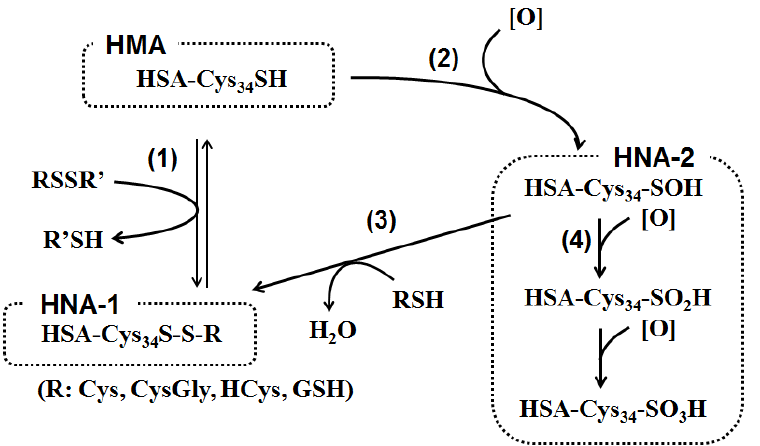
Figure 2. Pathway for human serum albumin (ALB) redox state. (1) The free thiol group in cysteine residue at position 34 (Cys34) of human serum mercaptalbumin (HMA) receives a disulfide exchange reaction with low molecular weight disulfides consisting of cysteine (Cys), cysteinylglycine (CysGly), homocysteine (HCys) and/or glutathione (GSH), to form a mixed disulfide on Cys34. The resulting oxidized ALB is designated as human non-mercaptalbumin-1 (HNA-1). (2) Alternatively, the Cys34 reacts with several reactive oxygen and nitrogen species such as hydrogen peroxide (H 2 O 2 ), peroxynitrite (ONOO − ), superoxide (O 2 − ), or hypochlorous acid (HOCl), and is initially oxidized to sulfenic acid. (3) Sulfenic acid reacts with cysteine and other thiols to form HNA-1. (4) On the other hand, sulfenic acid is further oxidized by reactive oxygen species to sulfinic and sulfonic acid. These oxidized ALB isoforms are designated as HNA-2.